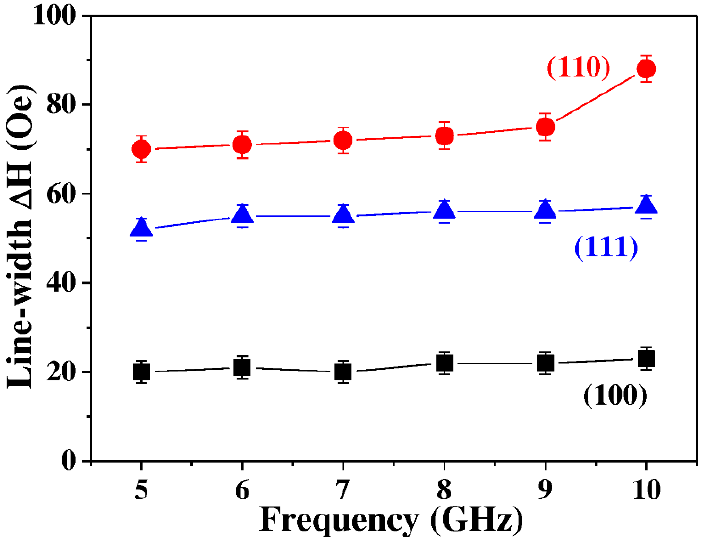
Figure 8. Dependence of FMR line-width Δ H on film thickness for 380 nm thick YIG film grown on (100) YAG, 205 nm film on (110) YAG, and 357 nm film on (111) YAG substrates. The ±3 Oe error bars of FMR line-width are presented in the figure.